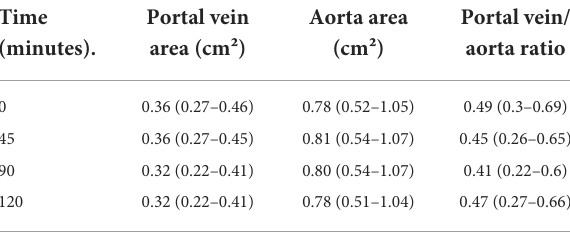
TABLE 2 Average portal vein area, aorta, and portal vein area to aorta ratio.